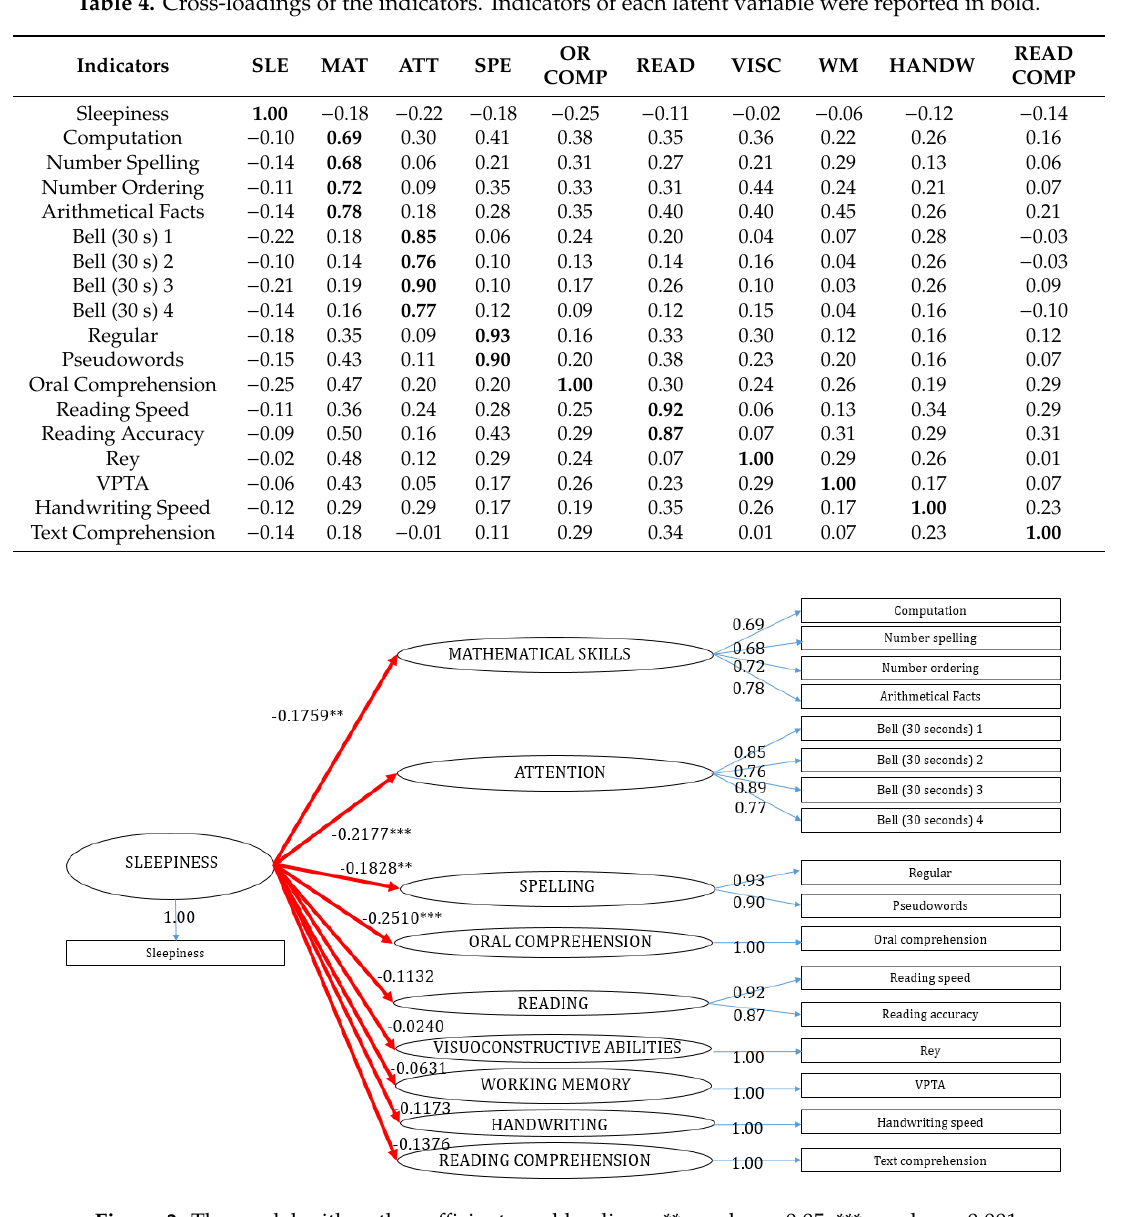
Figure 3. The model with path coefficients and loadings. ** p -value < 0.05 *** p -value < 0.001.